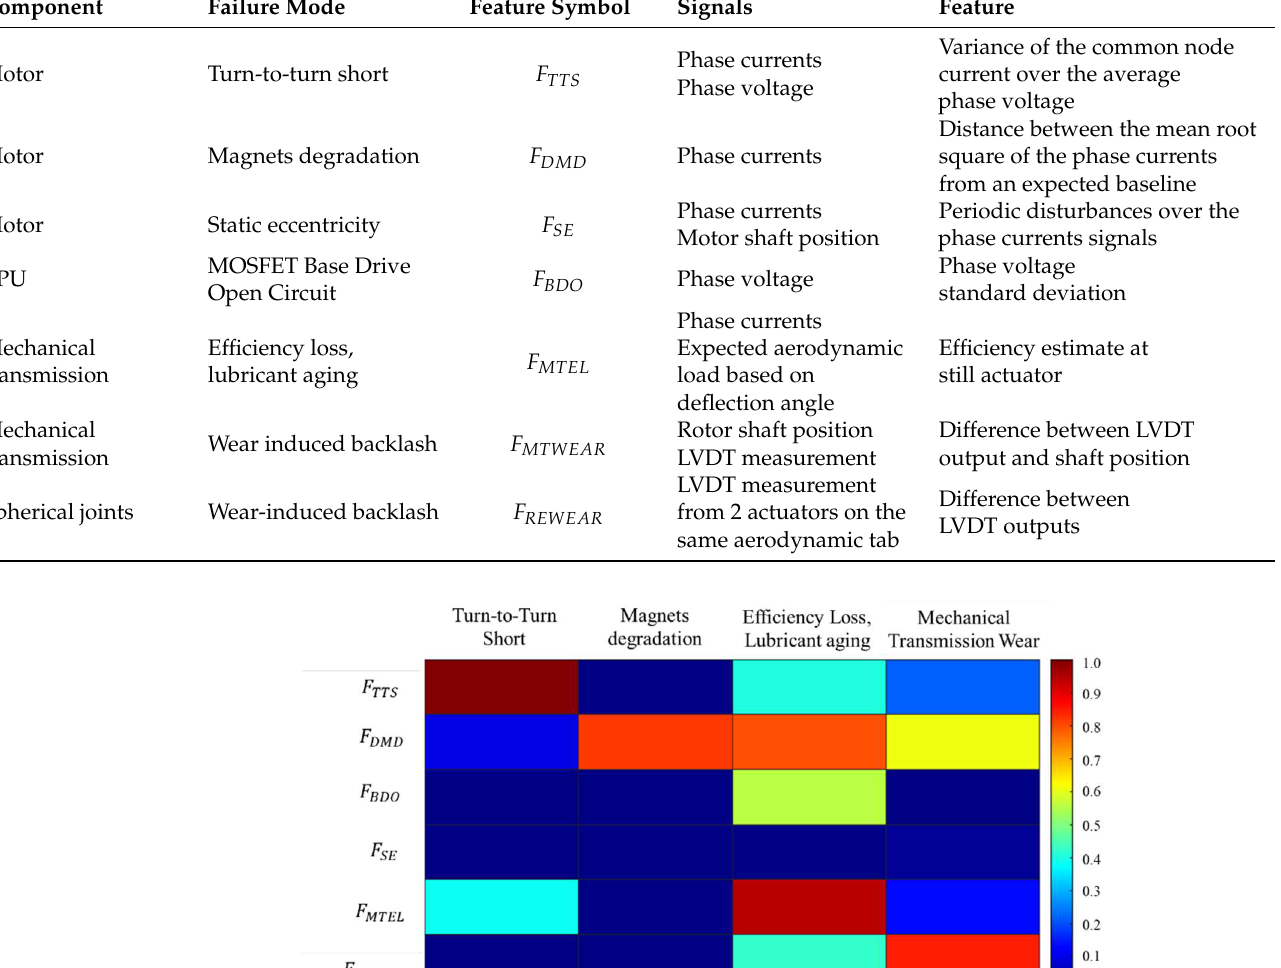
Table 1. Selected features.